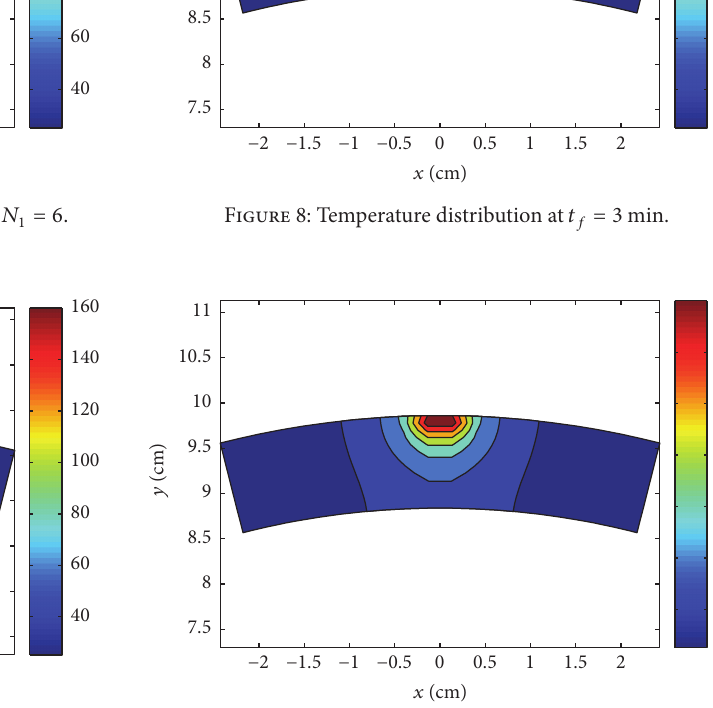
Figure 9: Temperature distribution at 𝑡 𝑓 = 30